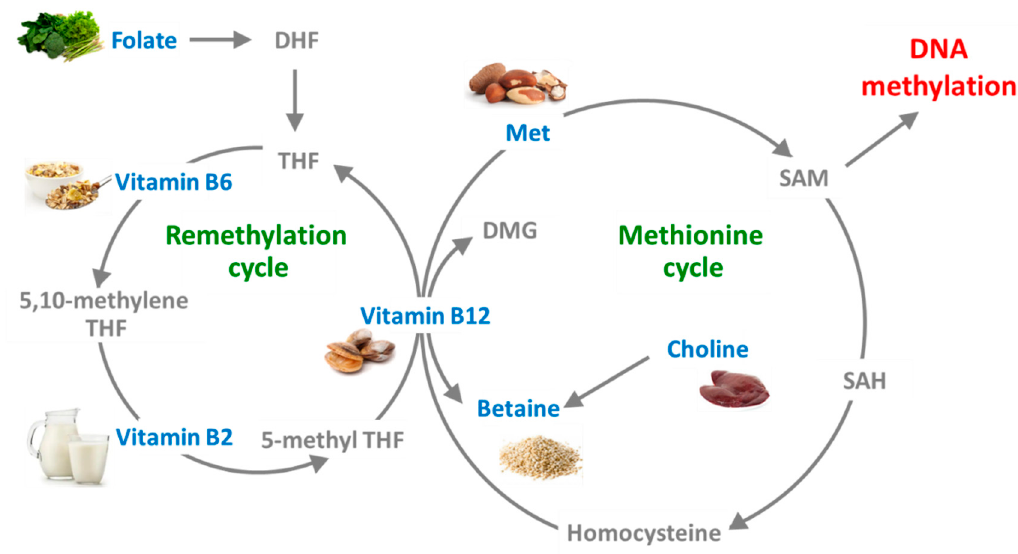
Figure 3. Schematic representation of one-carbon metabolism. DHF, dihydrofolate; DMG, N,N- dimethylglycine betaine; Met, methionine; SAH, S-adenosylhomocysteine; SAM, S-adenosylmethionine; THF, tetrahydrofolate.